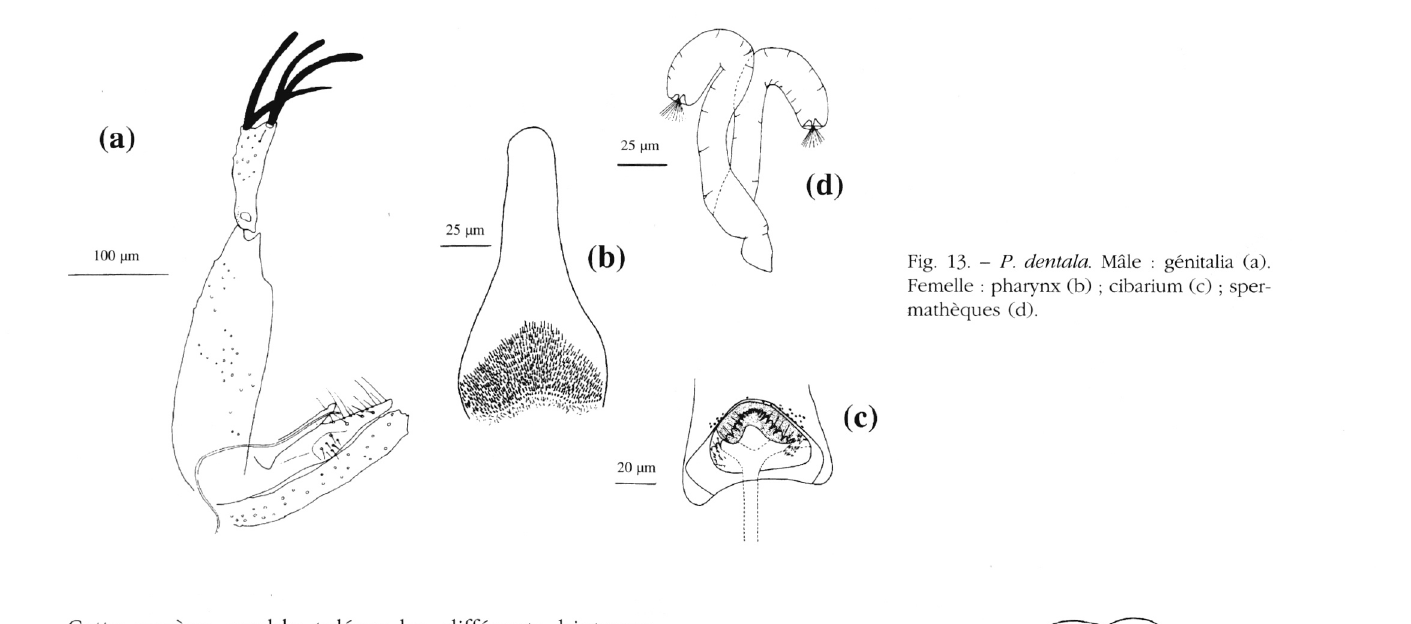
Fig. 13. - P. dentala. Mâle : génitalia (a). Femelle : pharynx (b) ; cibarium (c) ; sper- mathèques (d).